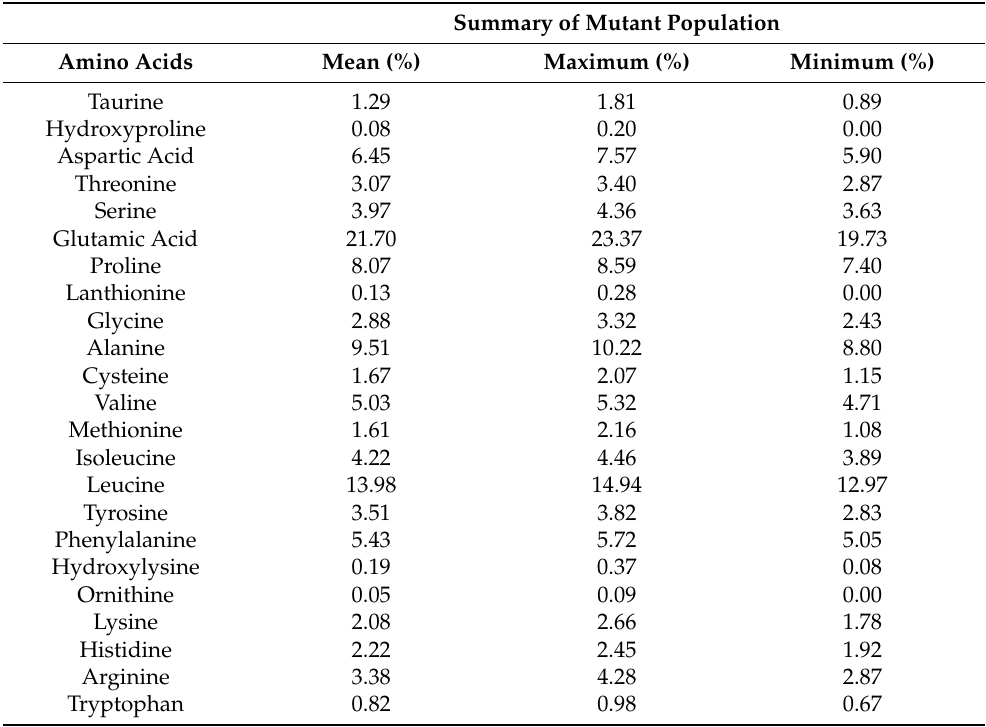
Table 1. Summary of the amino acid analysis of 206 sorghum mutant lines. Summary of Mutant